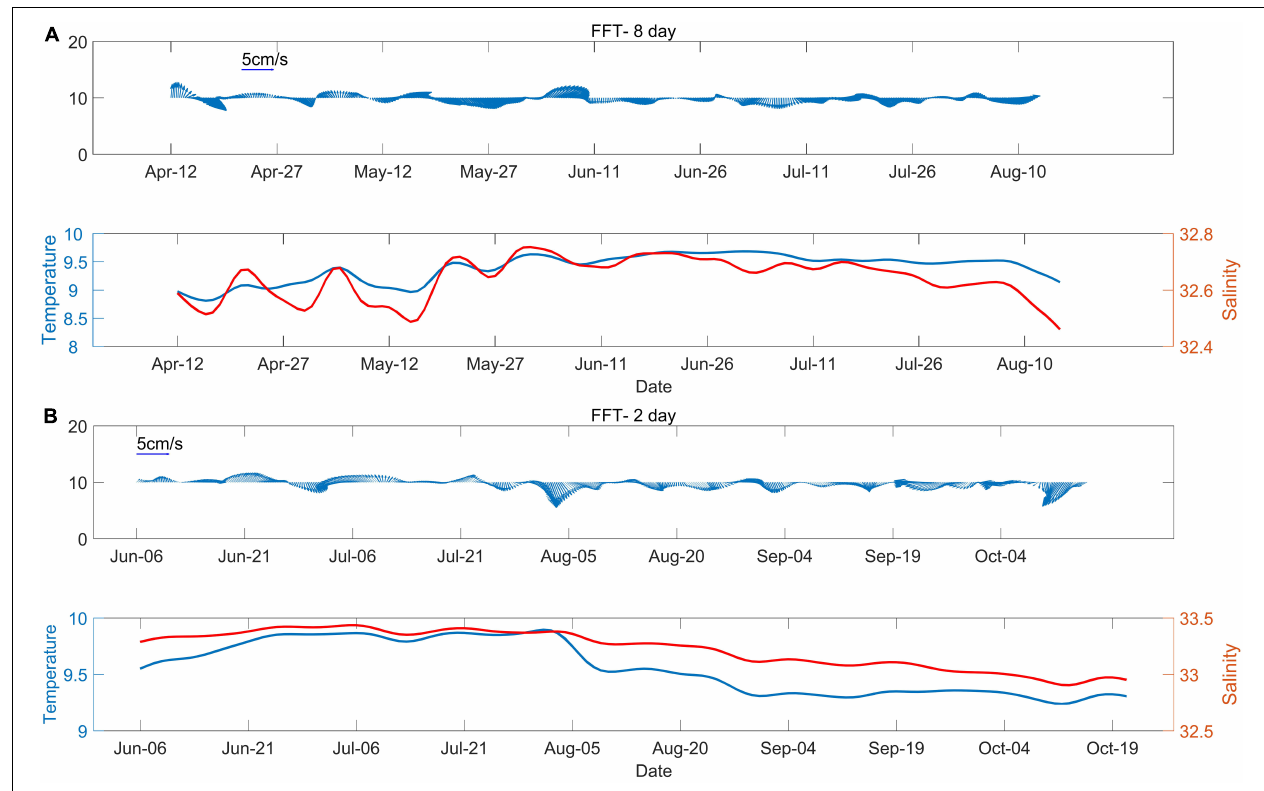
FIGURE 4 | The bottom current, temperature and salinity time series from April 11, 2013 to August 16, 2013 (A) and the bottom current, temperature and salinity time series from June 5, 2014 to October 23, 2014 (B) .